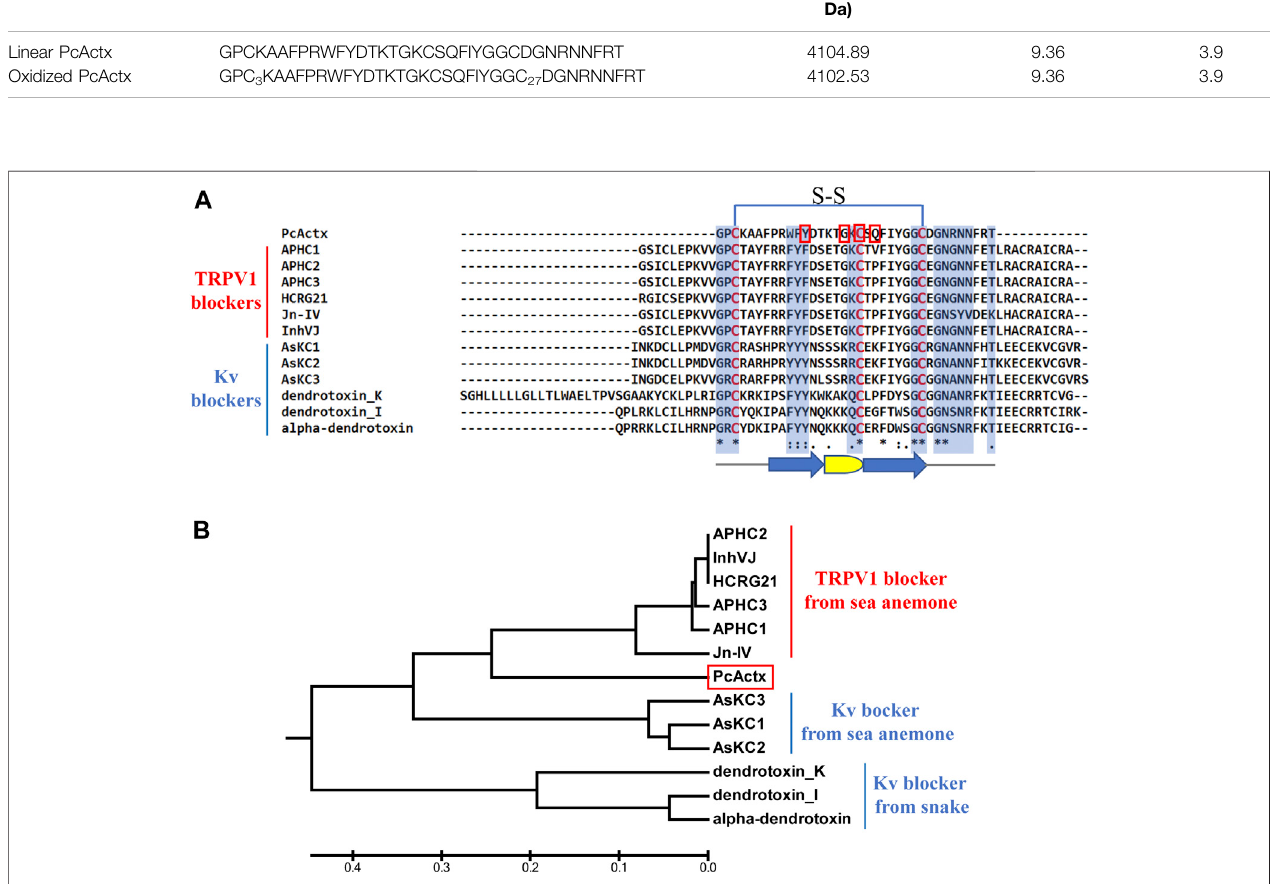
FIGURE 1 | Multiple sequence alignment and phylogenetic analysis of PcActx peptide from P. caribaeorum. (A) . Multiple sequence alignment of PcActx peptide and TRPV1 blockers originating from sea anemone, as well as Kv blockers originating from sea anemone and snake. Residues highlighted in blue are the key sites interacting with ion channels. Residues highlighted in red are the interactive sites of PcActx peptides binding to the TRPV1 channel. The arrow symbols represent β -sheet, and the semicircle represents β -turn. (B) . Phylogenetic tree of PcActx peptide.